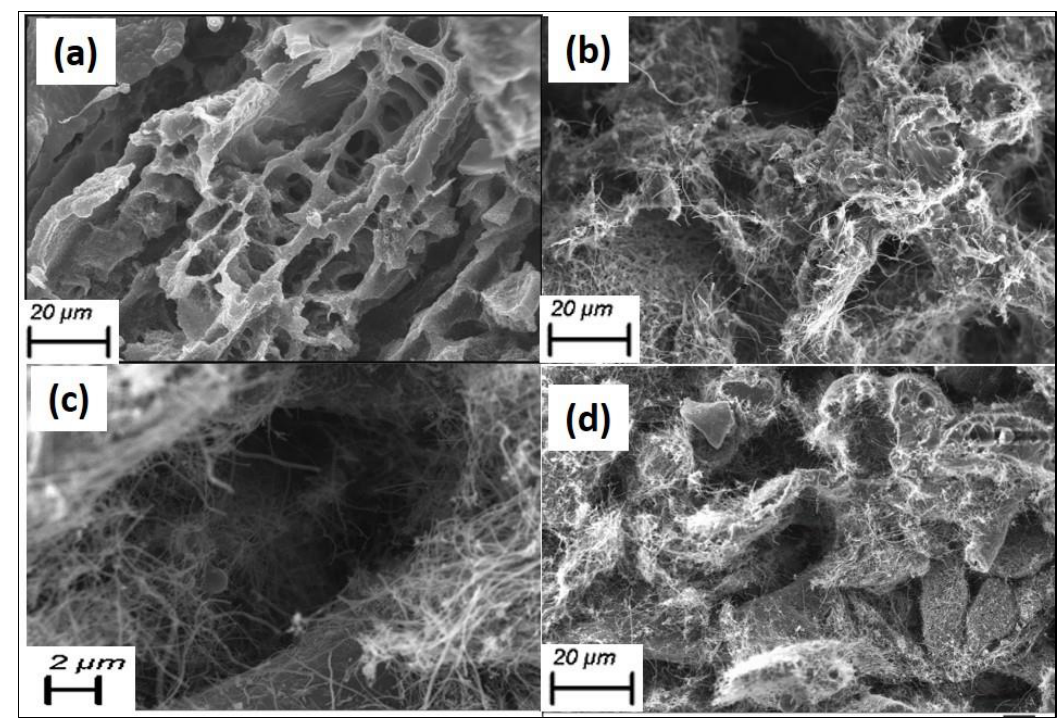
Figure 3. Morphological analysis of the SF and SF with CNF samples at ( a ) SF at 20 µm resolution; ( b ) SF with CNF density equal to 0.3%; ( c ) high magnification of SF with CNF density equal to 0.4% at 2 µm resolution; ( d ) SF with CNF density equal to 0.5% at 20 µm resolution.